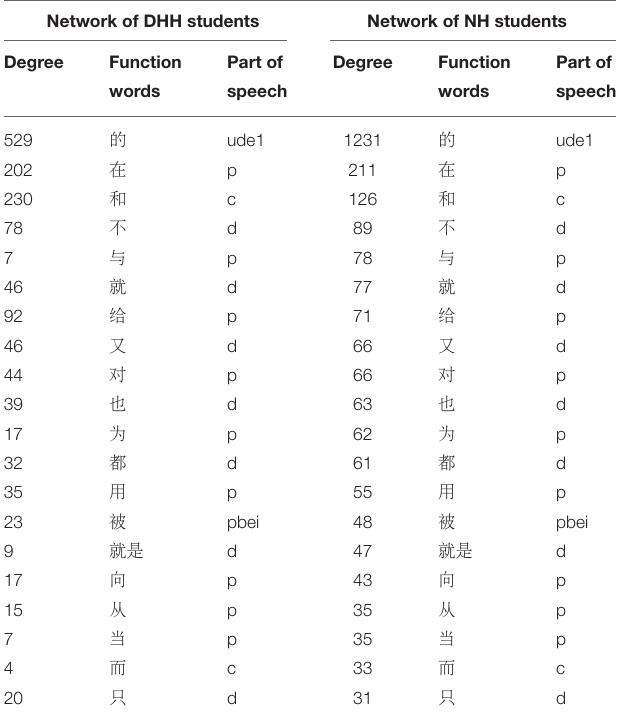
TABLE 4 | 6 Degree of 20 function words in the two networks 7